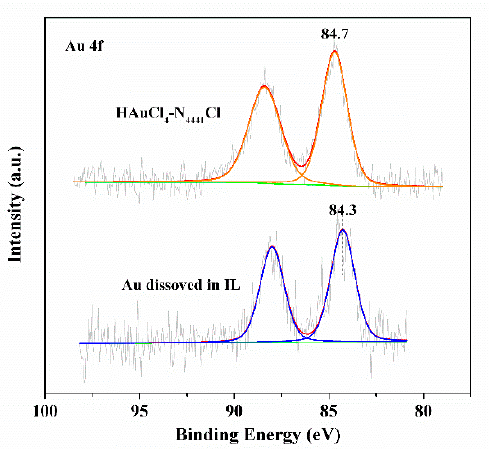
Figure 4. XPS result of the ionic liquid system after dissolving gold and the mixture of N 4441 Cl and HAuCl 4 .